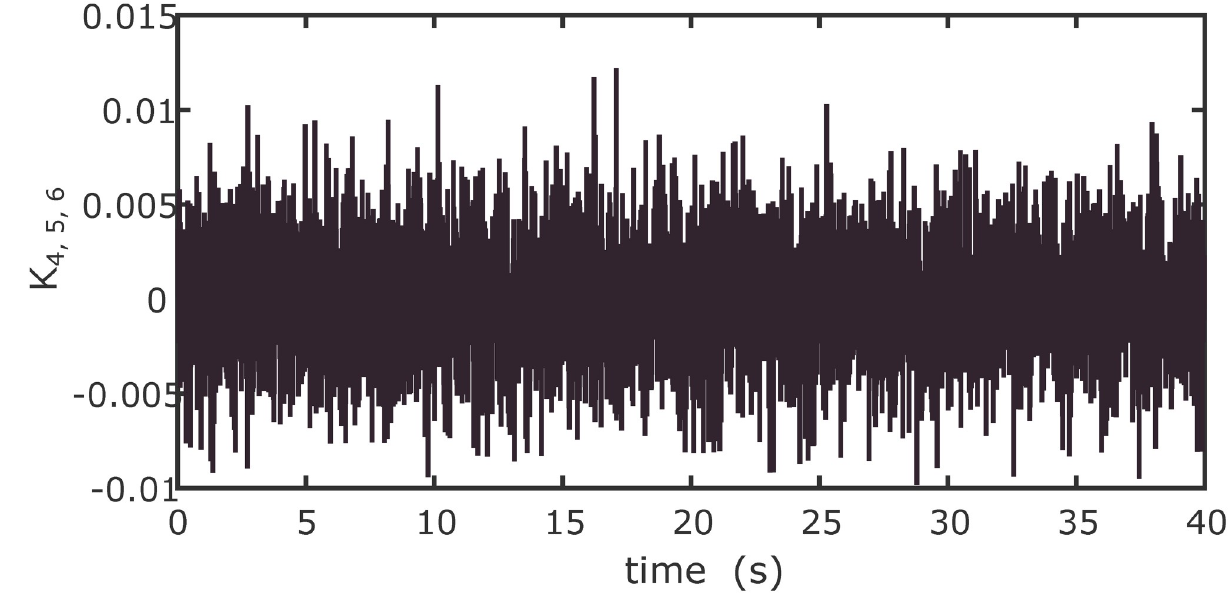
Fig 3. Drag coefficients for translational motion.